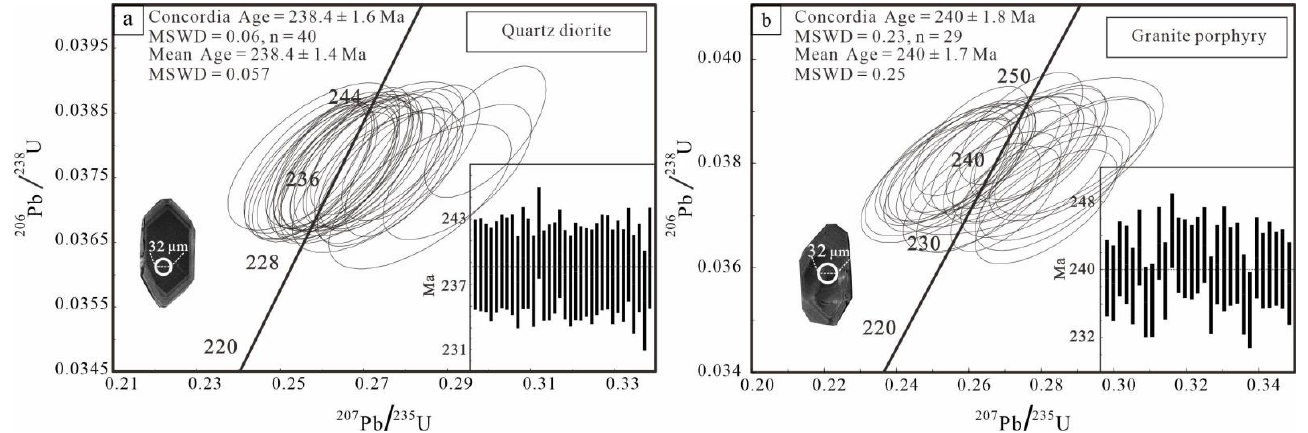
Figure 4. Zircon U - Pb isotope concordia plot for quartz diorite ( a ) and granite porphyry ( b ) in Asiha gold deposit.